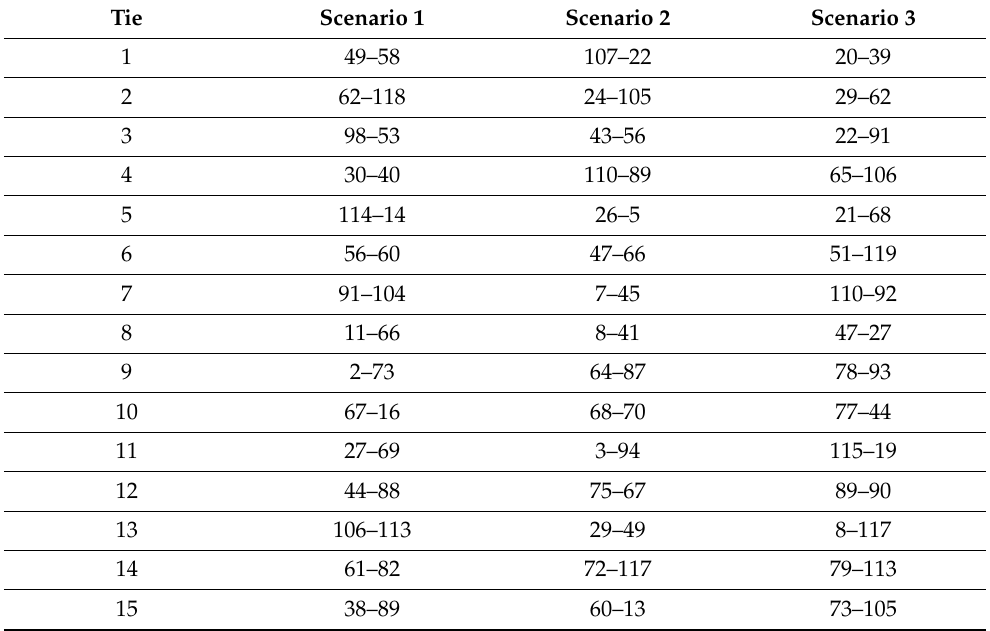
Table 6. Optimal tie-switch connections through reconfiguration in an IEEE 119-bus system.